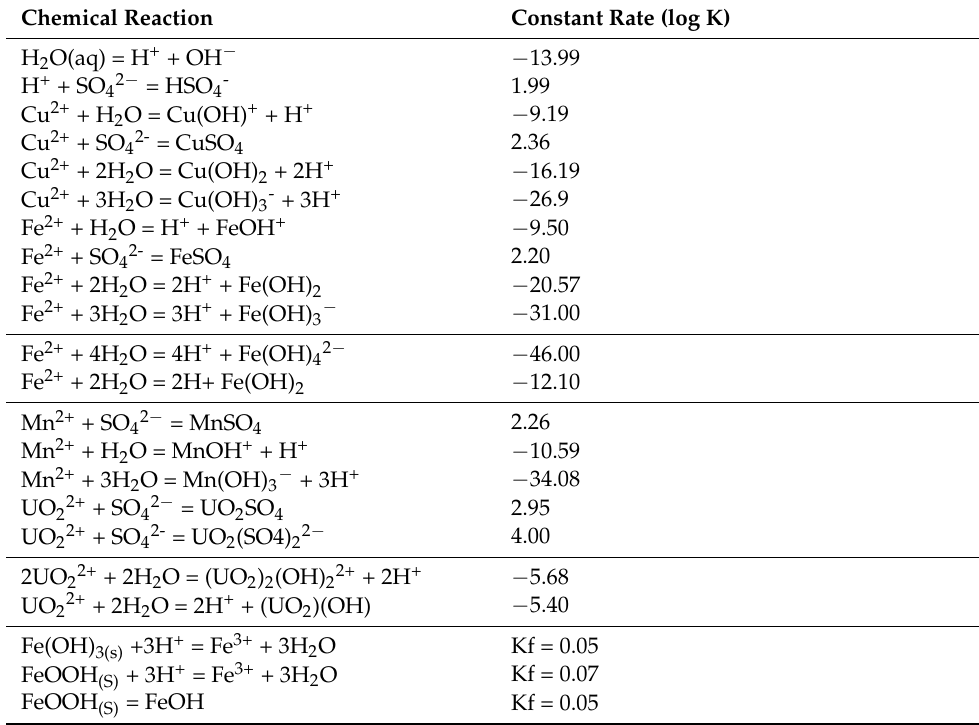
Table 3. Typical chemical reactions during contaminant